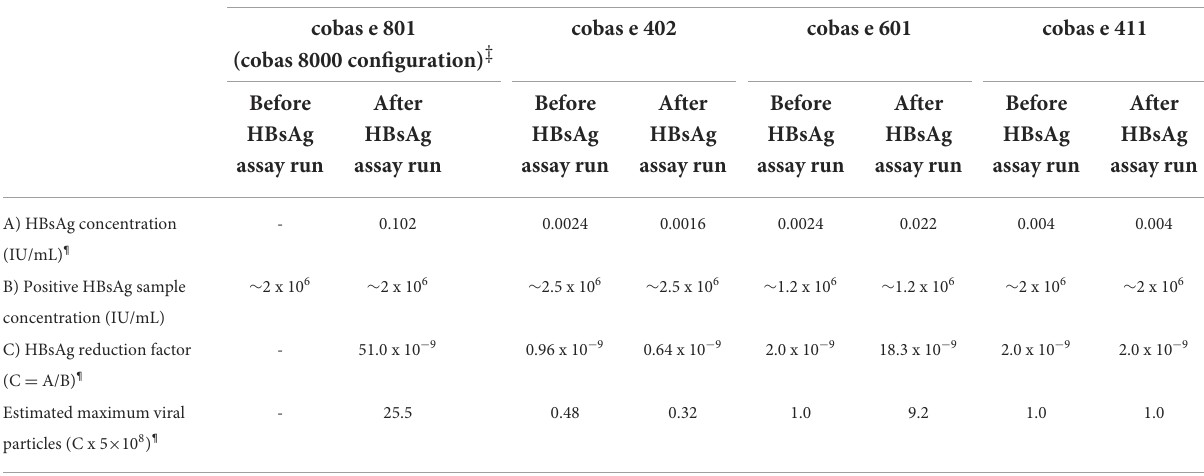
TABLE 2 Overview of the calculations and results for swab testing *, † . Overview of experimental